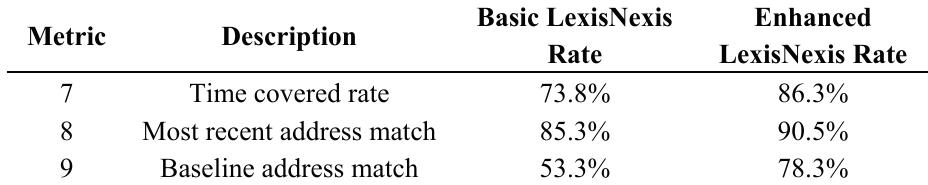
Table 5. Mean match rate for Metric 7 of time covered rate, Metric 8 of most recent address match, and Metric 9 of baseline address match for the basic and enhanced LexisNexis